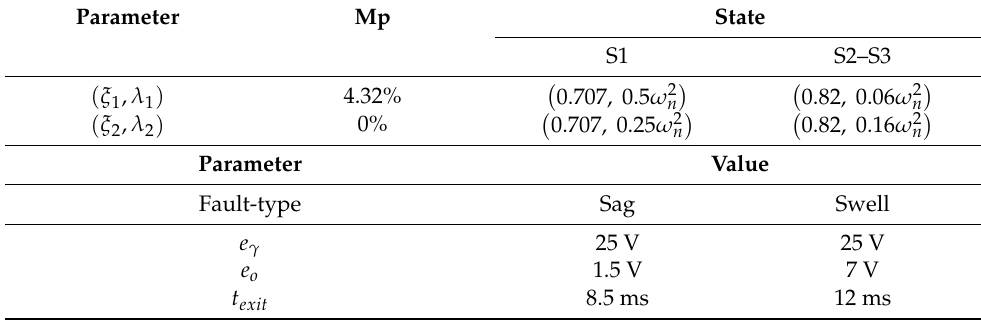
Table 1. SOGI-FLL-EbA parameters responding to voltage sags and